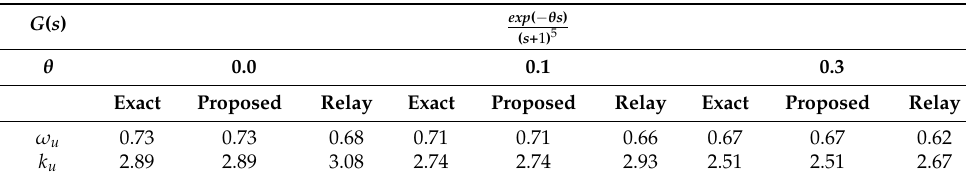
Table 3. Estimates of the proposed method and the relay feedback method [1] for the high-order plus time-delay process and PA set = − π .